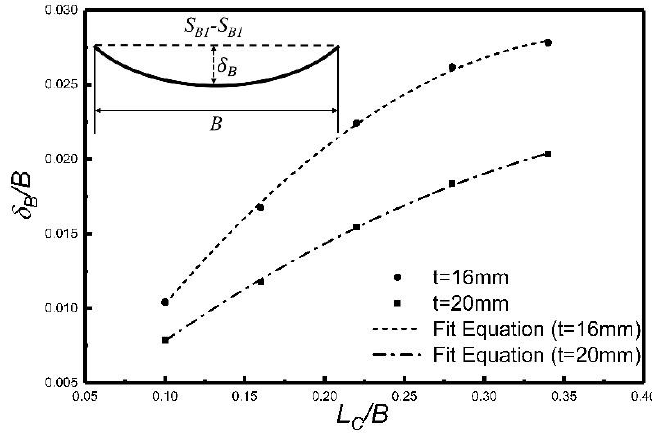
Figure 12. Effect of coil width on the transversal bending deflection.